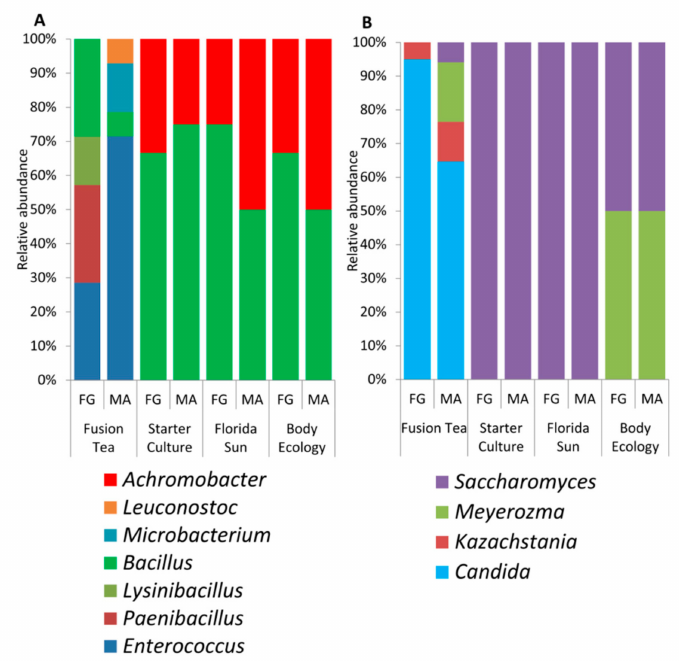
Figure 2. Diversity and relative abundance of bacterial ( a ) and yeast genera ( b ) isolated by culture-dependent approach from fresh (FG) and milk-activated (MA)